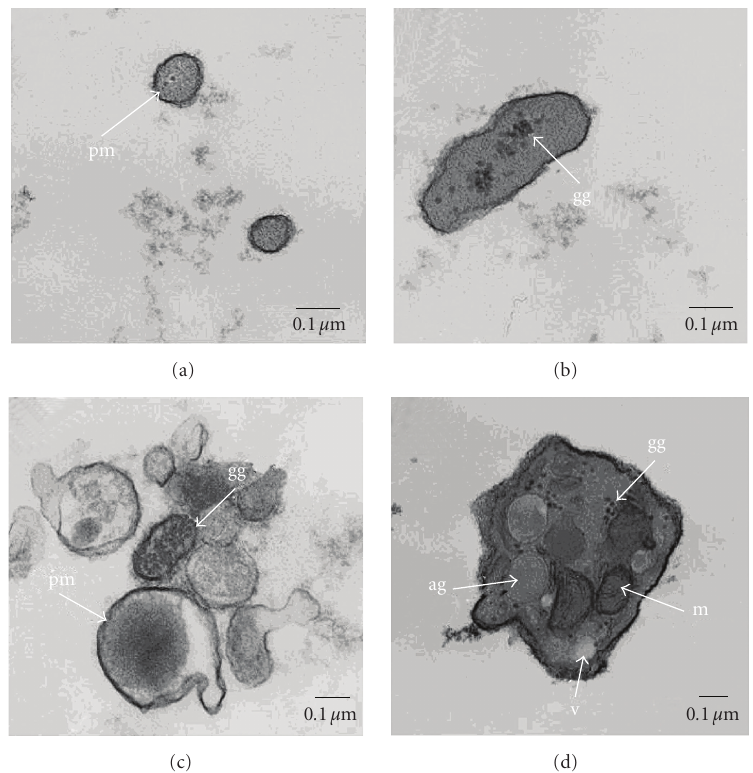
Figure 1: Various sized microparticles were isolated from platelet-free plasma from a normal subject and analyzed by transmission electron microscopy. (a–d) Smallest particles noted around 0.2 μ m in size. Note intact plasma membrane (pm) and various intracellular organelle remnants including Platelet microparticle (d). Note abundance of glycogen granules (gg), mitochondria (m), vacuole (v), and alpha granules (ag). Scale bar = 0.1 μ